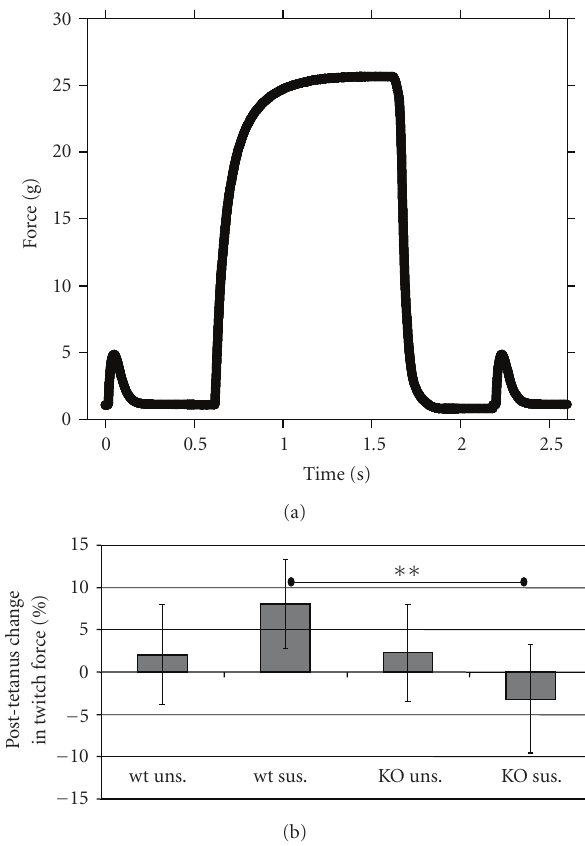
Figure 5: Twitch potentiation. (a) example of protocol. A twitch was elicited before and following a tetanus contraction and peak twitch force after contraction was compared to that before. (b) There is a significant di ff erence between the wt suspended and KO suspended in twitch potentiation, indicating a di ff erence in MLC phosophorylation between the wt and KO